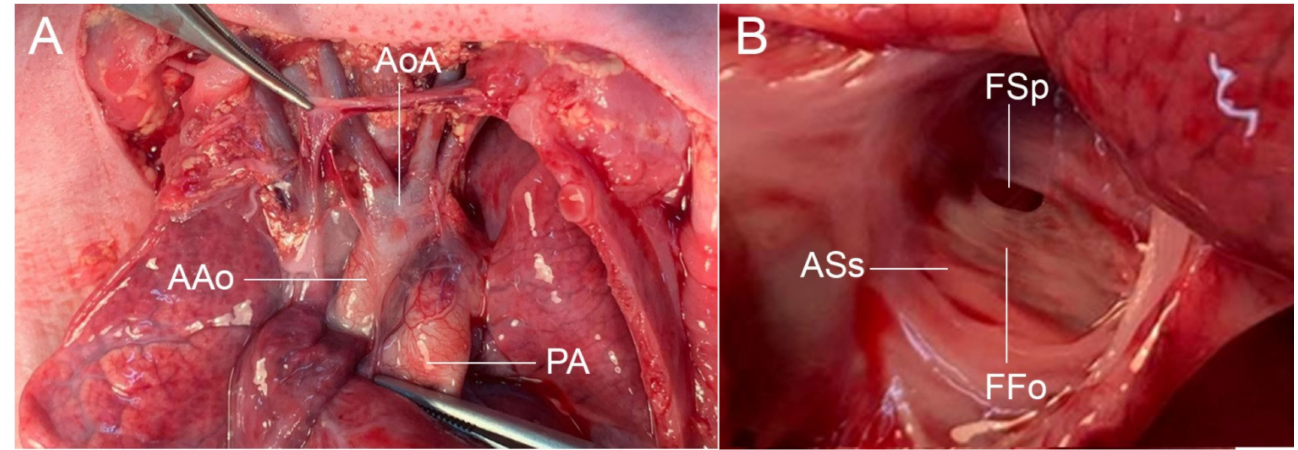
Figure 4. Autopsy findings: ( A ) small AAo and AoA, when compared with PA; ( B ) small FSp (AAo: ascending aorta; AoA: aortic arch; ASs: atrial septum secondum; FFo: flap of the foramen ovale; FSp: foramen of the septum primum; PA: pulmonary